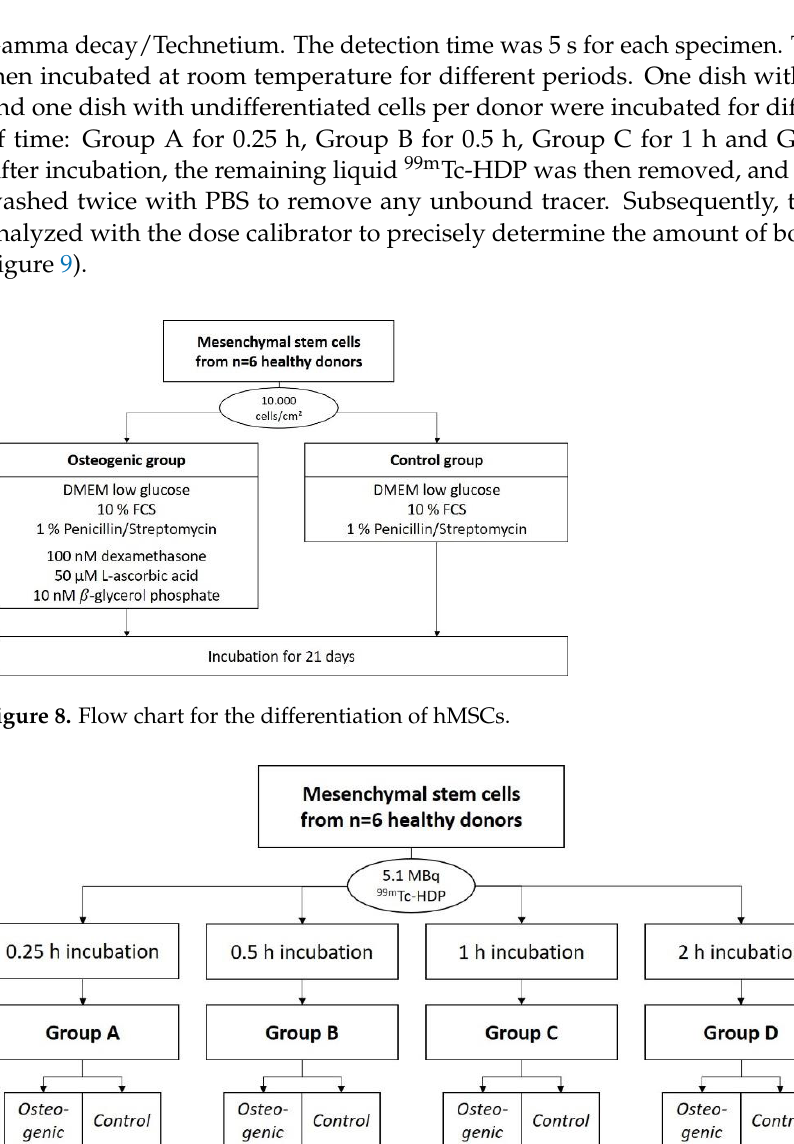
Figure 8. Flow chart for the differentiation of hMSCs.